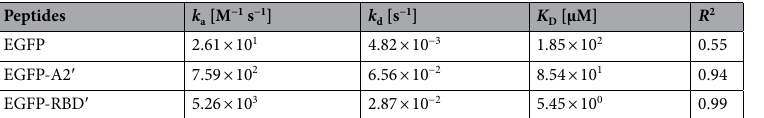
Table 1. Equilibrium dissociation constant ( K D = k d / k a ) and apparent association ( k a ) and dissociation ( k d ) rate constants for the interaction of SV2C-LD with EGFP, EGFP-A2 ʹ , and EGFP-RBD ʹ , determined from the bio- layer interferometric result.